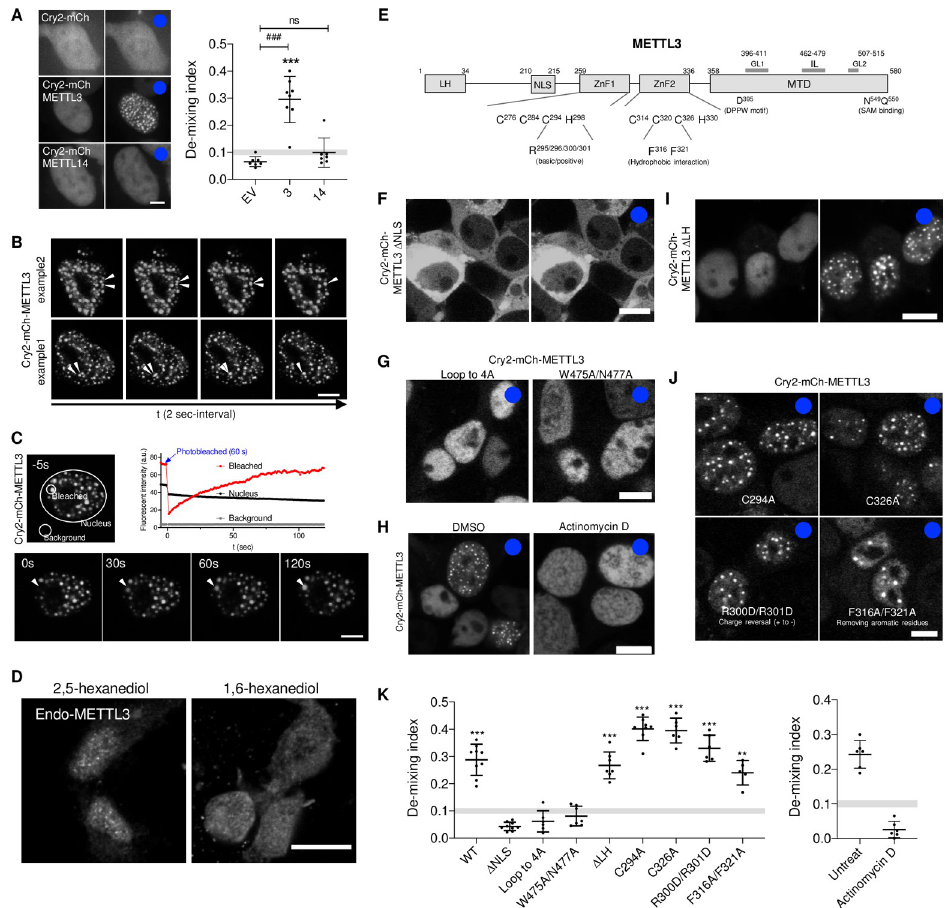
Fig 1. LLPS of Cry2-mCherry-METTL3. (A) (Left) Representative confocal images of HEK293T expressing Cry2-mCherry constructs before and after (blue dots) blue light (488 nm) stimulation. (Right) Demixing index at 300 seconds of blue light stimulation was quantified by CV across the nucleus. Gray area (0.09~0.11) is set as threshold of condensate formation. See S1C Fig. Scale bar = 5 μ m, Student t test used to compare between samples ###, P < 0.001; ns, nonsignificant. One-sample t test used to compare demixing index above gray area to hypothetical threshold (0.11) ��� , P < 0.001, error bars represent mean ± SD ( n = 7 for EV and METTL3 and n = 8 for METTL14). EV (Cry2-mCherry); 3, Cry2-mCh-METTL3; and 14, Cry2-mCh-METTL14. (B) Two representative time series images of Cry2-mCherry-METTL3 showing fusion events. White arrowheads track the fusion of 2 condensates. Time interval = 2 seconds. Scale bar = 5 μ m. (C) Representative time series images from 3 independent FRAP experiments using Cry2-mCh-METTL3 expressing HEK293T cells (top images) and quantitation of fluorescent intensity (bottom plot). Arrowhead tracks bleached area. Fluorescent intensity was measured using ImageJ software. Scale bar = 5 μ m. (D) Representative images of endogenous METTL3 in HeLa cells treated with 5% 2,5- or 1,6-hexanediol for 5 minutes. Scale bar = 20 μ m. (E) Schematic diagram of METTL3 domains. (F) Representative images showing localization and protein distribution of Cry2-mCh-METTL3 Δ NLS before (left) and after (right, blue dot) blue light stimulation. Scale bar = 10 μ m. (G) Light stimulation of METTL14 binding–deficient mutants of Cry2-mCh-METTL3. Blue dot indicates light stimulation. Scale bar = 10 μ m. (H) Light-inducible condensate formation of Cry2-mCh-METTL3 (wild-type) with Actinomycin D (2 μ g/ml) or vehicle (DMSO). Blue dots indicate light stimulation. Scale bar = 10 μ m. (I) Light stimulation of Cry2-mCh-METTL3 Δ LH mutant. Blue dot indicates light stimulation. Scale bar = 10 μ m. (J) Representative images showing protein distribution of Cry2-mCh-METTL3 ZnF1/2 mutant after (blue dot) blue light stimulation. Scale bar = 10 μ m. (K) Demixing index at 300 seconds of blue light stimulation was quantified with mutant constructs (Fig 1F, 1G, 1I, and 1J, left) and wild type with/without Actinomycin D (Fig 1H, right). Gray area (0.09~0.11) is set as threshold of condensate formation. One-sample t test used to compare demixing index above gray area to hypothetical threshold (0.11) �� , P < 0.01; ��� , P < 0.001, error bars represent mean ± SD ( n = 9 for WT and Δ NLS; n = 8 for C294A; n = 7 for W475A/N477A and Δ LH; n = 6 for loop to 4A, C326A, R300D/R301D, DMSO, and Actinomycin D; and n = 5 for F316A/F321A). The underlying data for the graphs presented can be found in S1 Values For Plots. a.u AU : AbbreviationlistshavebeencompiledforthoseusedinFigs 1 (cid:0) 4 : Pleaseverifythatallentriesarecorrect : ., arbitrary unit; CV, coefficient of variation; EV, empty vector; FRAP, fluorescence recovery after photobleaching; GL, gate loop; IL, interface loop; LH, leader helix; LLPS, liquid–liquid phase separation; MTD, methyltransferase domain; METTL3, methyltransferase-like 3; METTL14, methyltransferase-like 14; NLS, nuclear localization signal; ZnF, zinc-finger motif.